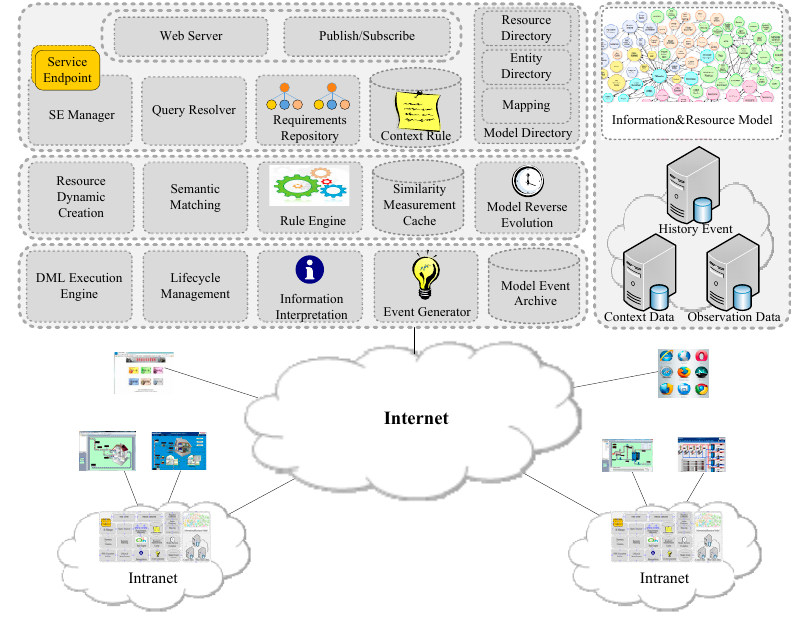
Figure 2. Internal architecture of resource platform.